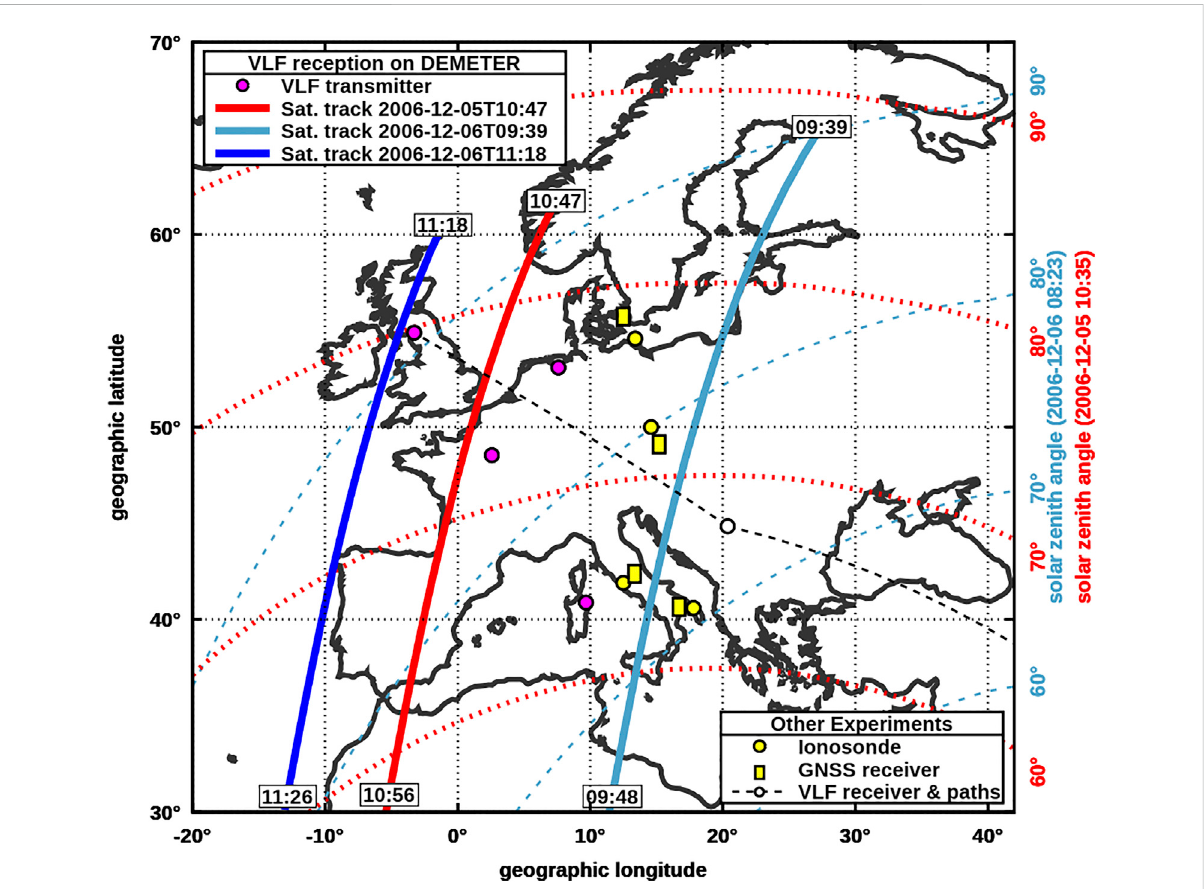
FIGURE 2 Locations of stations/experiments used in this study. The map shows VLF transmitters (magenta dots, north to south: GBZ/GQD in the United Kingdom, DHO in Germany, HWV in France, ICV in Italy) and the ground track of the DEMETER satellite during three separate passes that we used to detect the transmitter signals. Also shown are ionosonde stations (yellow dots, north to south: Juliusruh, Pruhonice, Rome and San Vito), GNSSreceivers(yellow squares,northtosouth:BUDP(Kobenhavn),KUNZ(Kunzak),AQUI(L ’ Aquila),MATE(Matera)),andonenarrow-bandVLF receiver station (white circle, Belgrade) listening to GQD (United Kingdom) and NWC (Australia) transmitters, with the great circle paths between the receiver and the transmitters shown as a black dashed line. In addition, solar zenith angle isolines during two fl are events are indicated (X9.0, peak time at 10:35 on 05 December, and M6, peak time at 08:23 UT on 06 December 2006, dashed